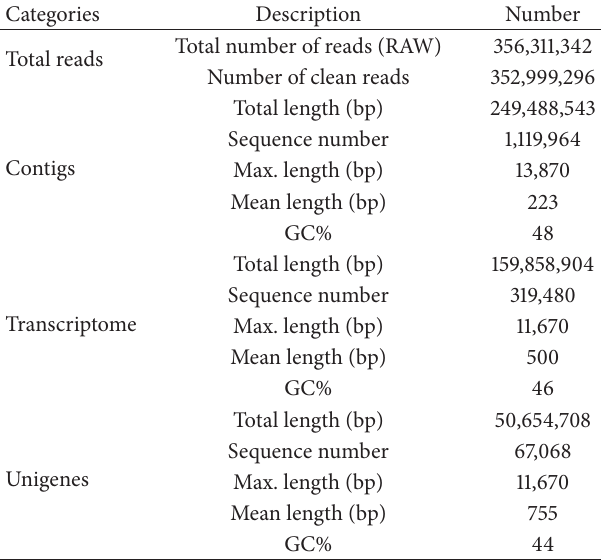
Table 1: Overview of the sequencing and assembly.